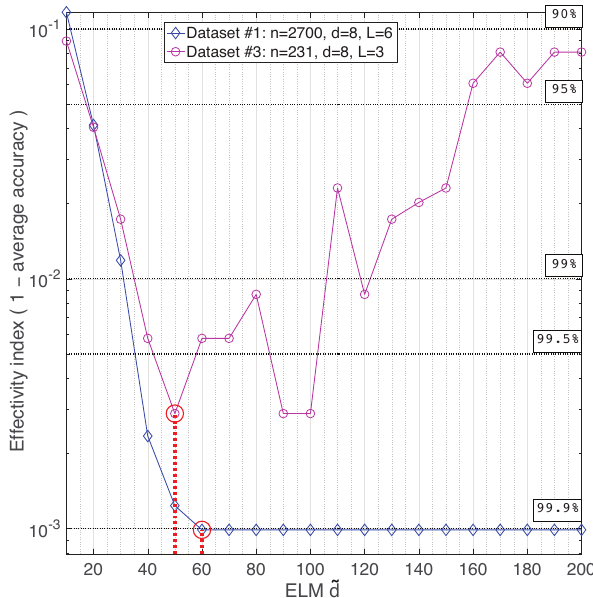
Figure 13. Average accuracy vs. the number of hidden layer nodes ELM ˜ d for datasets #1 and #3 in the training set (semi-logarithmic plot in the vertical axis). The vertical axis represents the effectivity index. The optimal selected parameters are highlighted in red. The accuracy range for dataset #1 is from 88.333% to 99.901% and that for dataset #3 is from 91.053% to